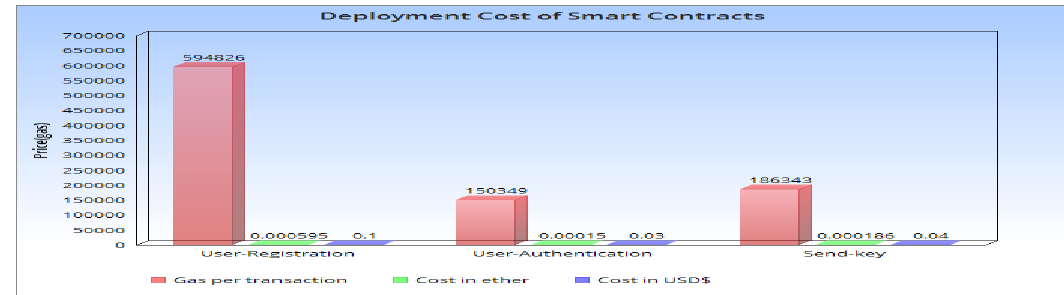
Fig. 3: Deployments Cost of Smart Contracts